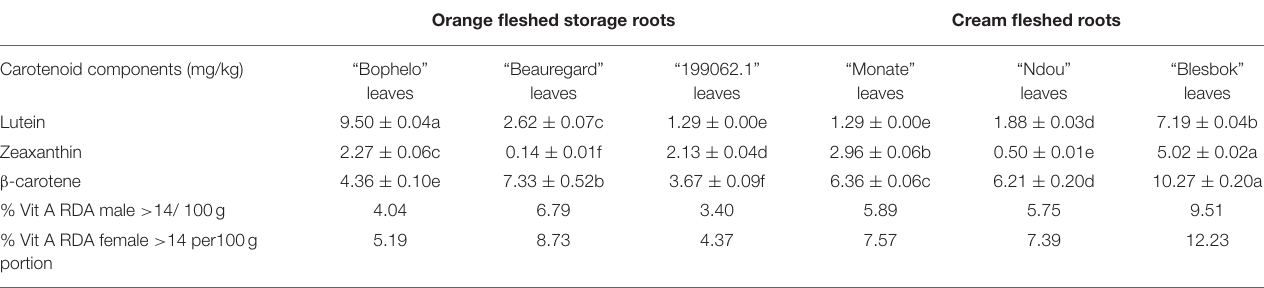
Orange fleshed storage roots Cream fleshed roots “Beauregard” “199062.1” “Monate” “Ndou” “Blesbok” leaves leaves leaves leaves leaves leaves